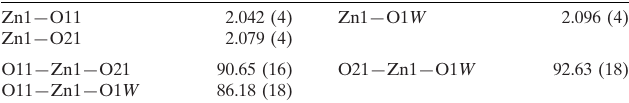
Selected geometric parameters (A˚ , (cid:4) ).